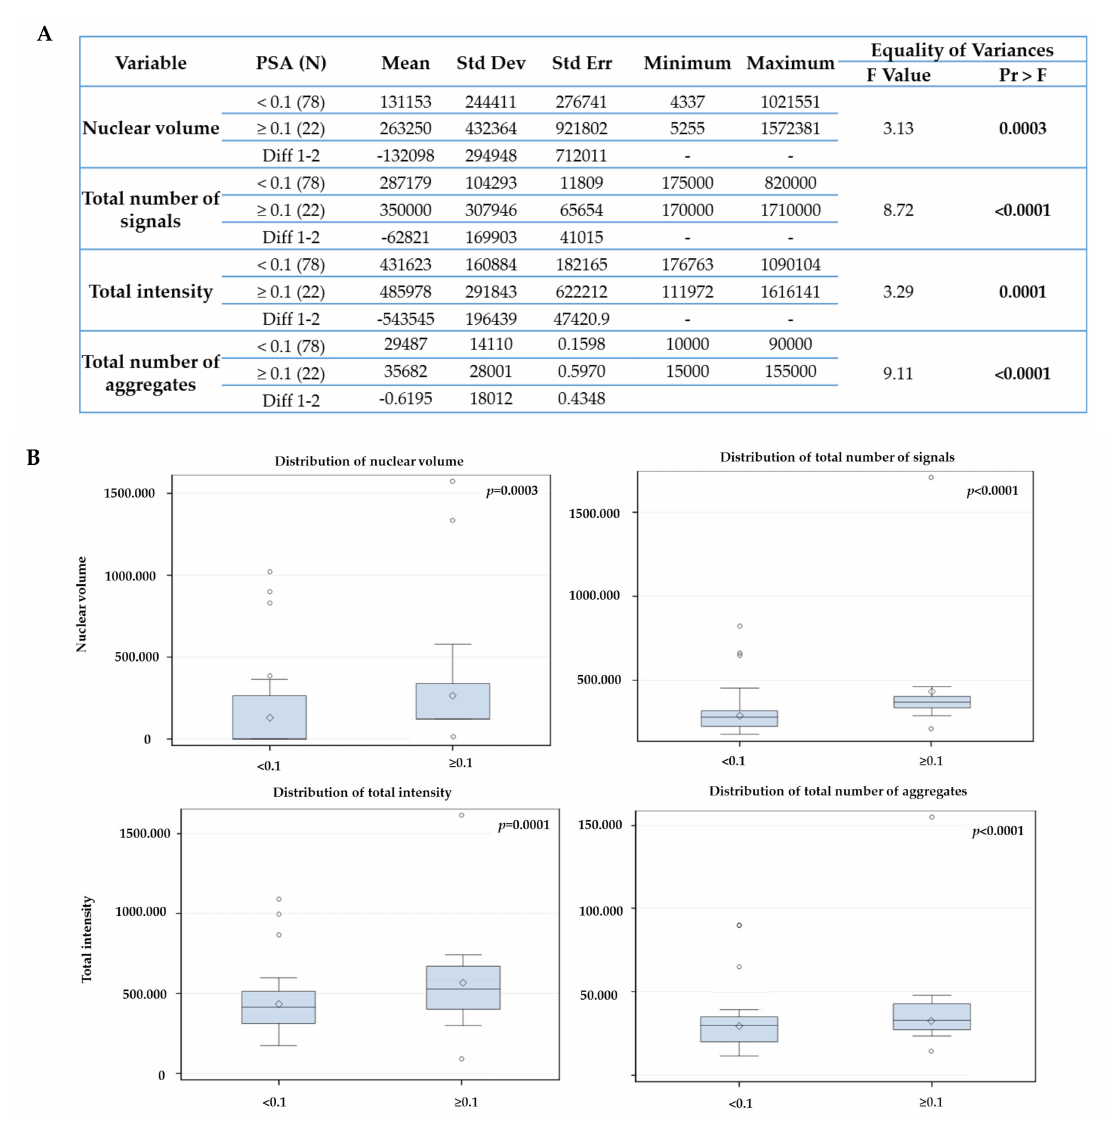
Figure 6. Statistical analysis comparing the telomeres parameters at 0 month with PSA value at 36 months after initial therapy using 0.1 ng / mL cuto ff ( A ). ( B ) Box-plots generated by Statistical Analysis Software v. 9.4. The box is divided in the following way: —the median is the middle line, the 50th percentile- the top of box is the 75th percentile- the bottom box is the 25th percentile. Concerning the whiskers, the upper top of whiskers represent the max observation 1.5 × (interquartile range (IQR)—75th percentile minus 25th percentile), while the bottom of whiskers represent the minimum observation 1.5 × (1QR from 25th). The observations plotted are outliers- beyond the 1.5 × IQR or below. The